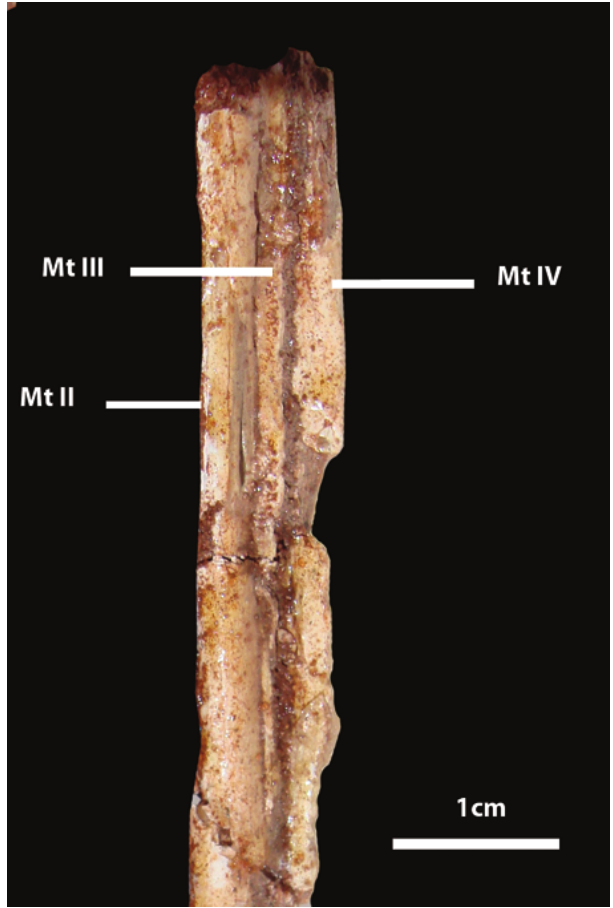
Fig. 3 – Proximal end of metatarsals in anterior